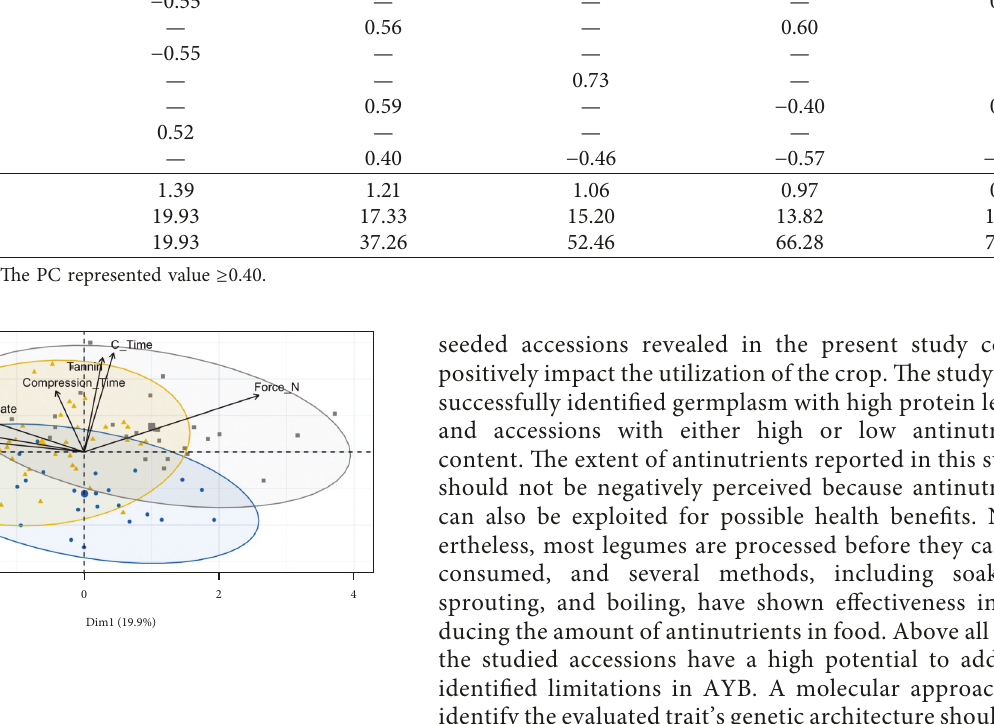
Table 6: Principal component (PC) analysis of textural and chemical properties of 93 AYB accessions. Parameter